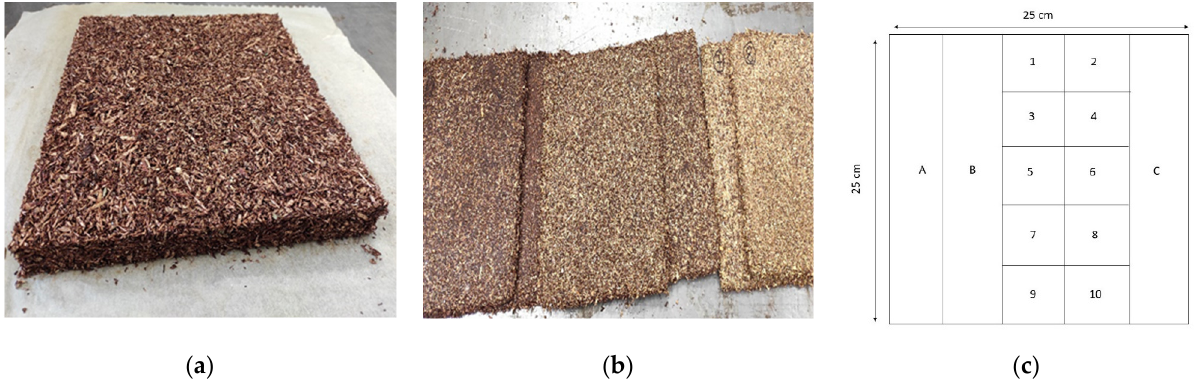
Figure 1. ( a ) Cold pre-pressed wood particles mat glued with 15% of quebracho-furfural adhesives ( b ) Particleboards with 32 × 32 × 1 cm size pressed at different glue amounts ( c ) Panel cutting section for samples manufacturing used for physical and mechanical analysis.